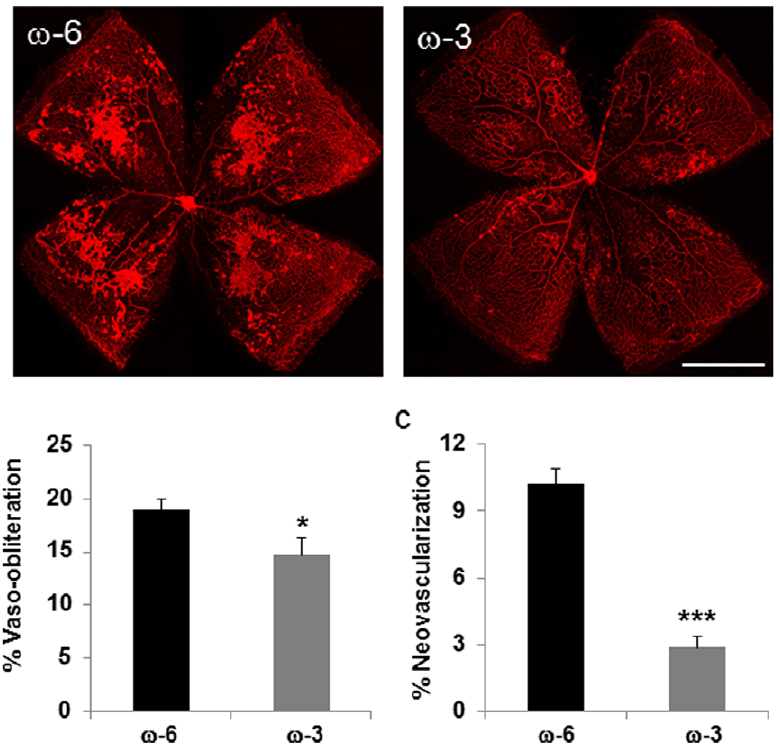
Figure 2. Dietary treatment of v -3 PUFA protects against pathologic retinal neovascularization. C57 BL/6 mouse pups fed with v -3 or v - 6 PUFA enhanced diet were exposed to oxygen-induced retinopathy. Retinas were flat mounted at postnatal day (P) 17 to visualize vasculature with contralateral retinas from the same mice isolated for gene array analysis. ( a ). Representative retina vasculature stained with isolectin B 4 shows vaso- obliteration and pathologic neovascularization in v -6 or v -3 fed mice. ( v -6, n=7 and v -3, n=8). Scale bar: 1mm. Quantification of ( b ) vaso- obliteration and ( c ) neovascularization in v -6 or v -3 fed mice. * P # 0.05, *** P # 0.001.